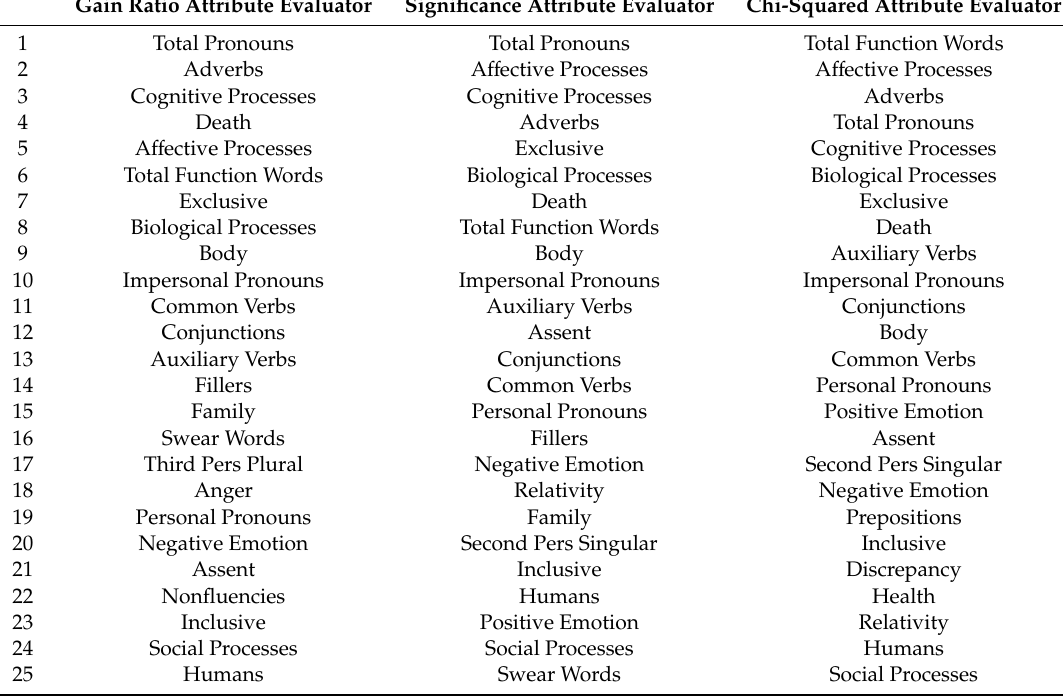
Table 4. Psycholinguistic features selected by di ff erent methods.